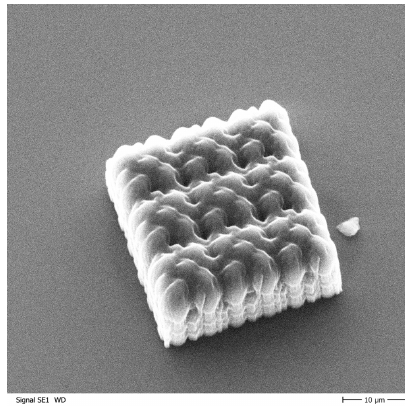
Figure 15. Quantity scale: octet structure